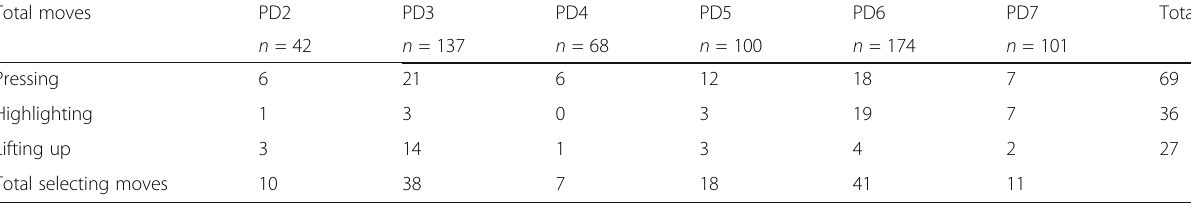
Table 4 Frequency of selecting moves across the TSCD-PD sessions